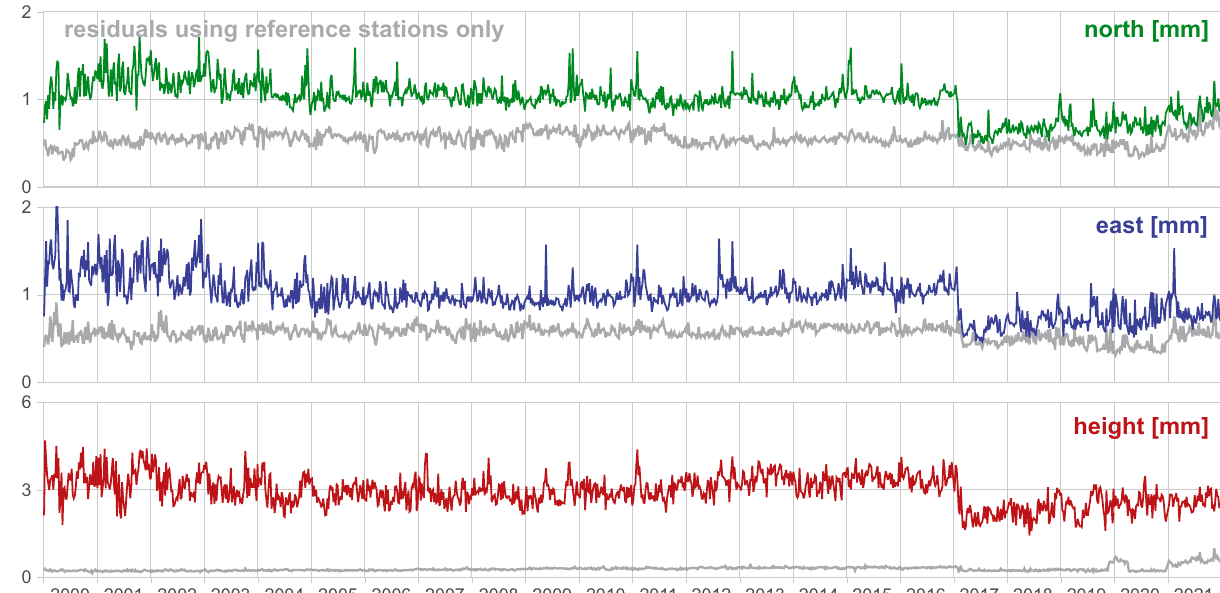
Figure 13: Mean RMS values of the station position residuals obtained after comparing the SIRGAS - Repro2 station positions and the weekly coordinates of the IGS stations in IGS14/IGb14. Grey lines represent the values obtained when comparing SIRGAS with the IGS fi ducial stations only; coloured lines represent the values obtained when comparing all SIRGAS/IGS common stations.